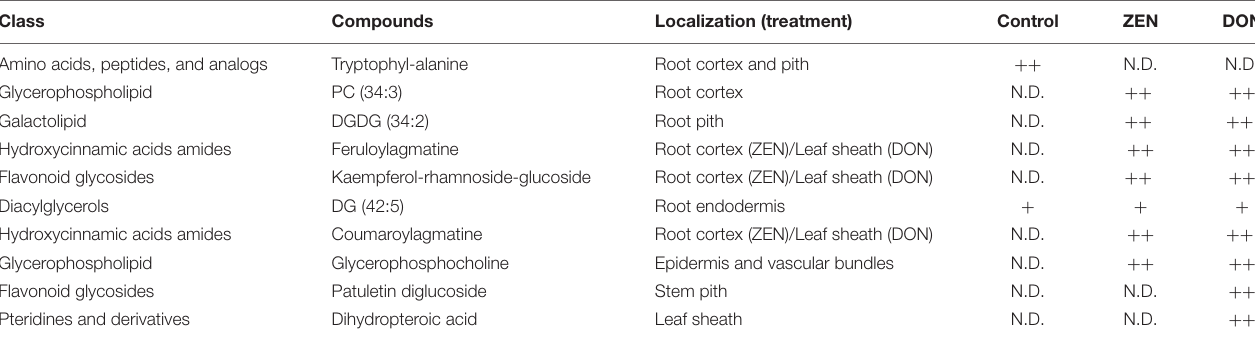
FIGURE 1 | Pie chart representing the mycotoxin biotransformation and distribution in the root (for ZEN) and in the whole plantlets (for DON). Each ring represents the total portion of parent toxin and its derivatives in the plantlets, considering the sum of signals quantified in roots and culm. (A) ZEN and its phase I and phase II metabolites quantified in the root. Their above-ground accumulation was below the limit of detection. (B) DON underwent biotransformation to a large extent into its glycosidic form. Fill pattern sections of the ring represent the portion of DON and DON3Glc translocated to the above-ground organs. TABLE 1 | Differentially accumulated metabolites in response to DON and ZEN treatment, whose m/z images are reported in the manuscript (qualitative abundance are reported as: N.D, not detected; + , detected with low relative abundance; ++ , detected with high relative